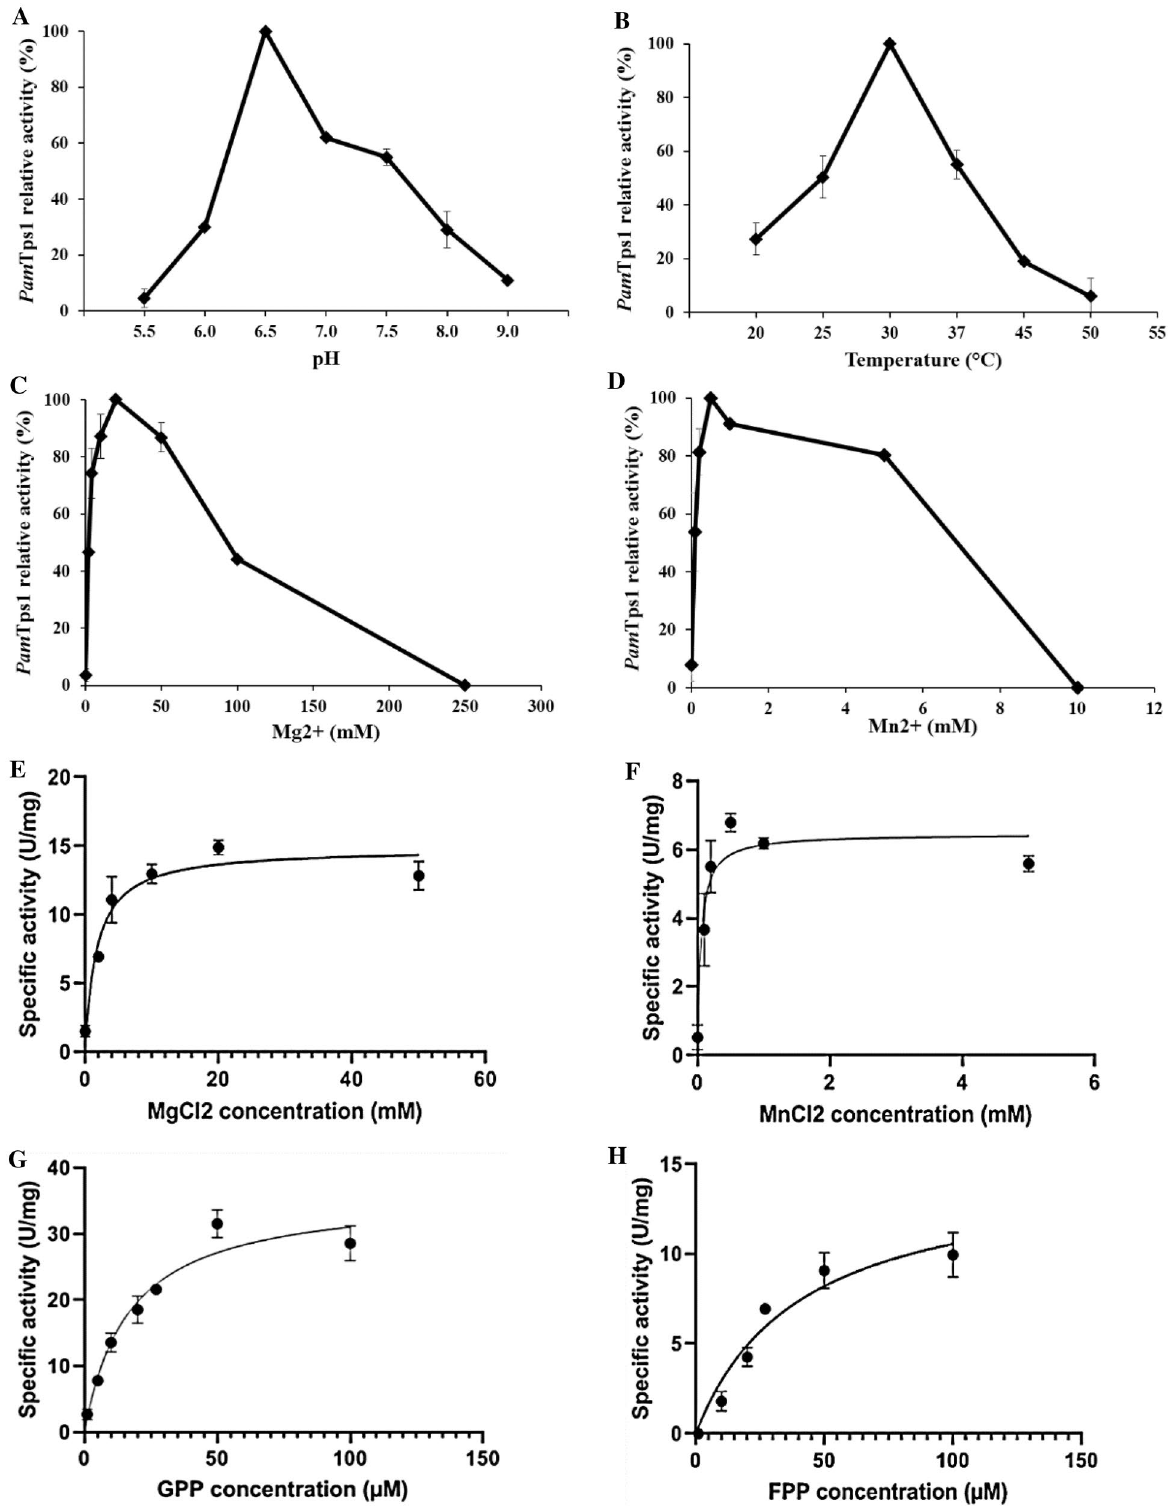
Figure 1. Biochemical characterization of Pam Tps1. ( A ) pH; ( B ) Temperature; ( C ) Mg 2+ concentrations; ( D ) Mn 2+ concentrations. Michaelis–Menten plot of Pam Tps1 at different concentrations of ( E ) Mn 2+ ; ( F ) Mg 2+ ; ( G ) GPP and ( H ) FPP. The saturation curve was constructed using Michaelis–Menten equation by hyperbolic regression. Values were reported as the mean of relative activity ± SD of triplicate